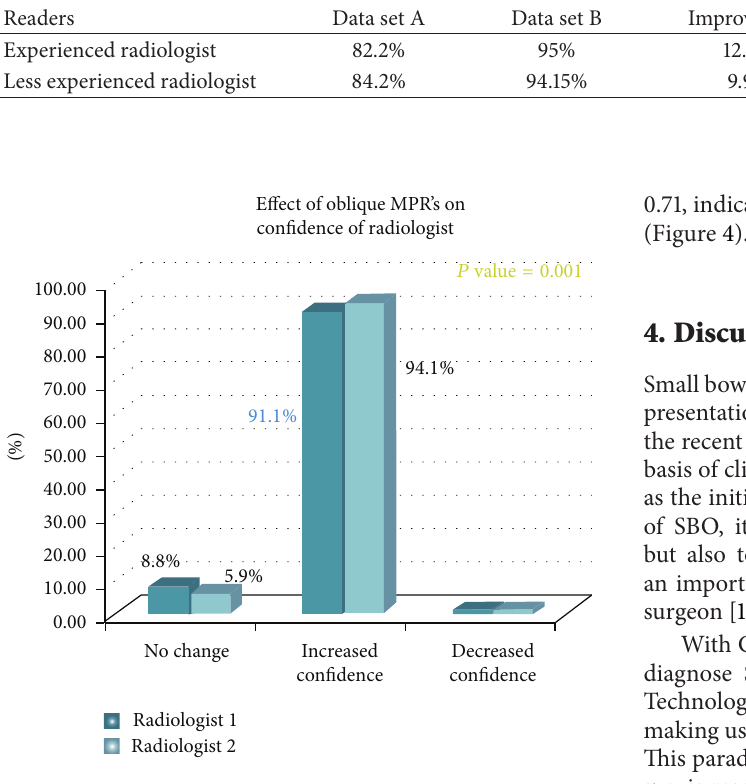
Figure 1: Effect of oblique MPRs on confidence of radiologist in diagnosing point of